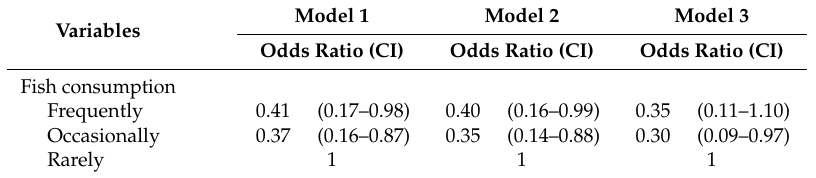
Table 5. Multiple logistic regression of fish consumption related to depressive symptoms in men.